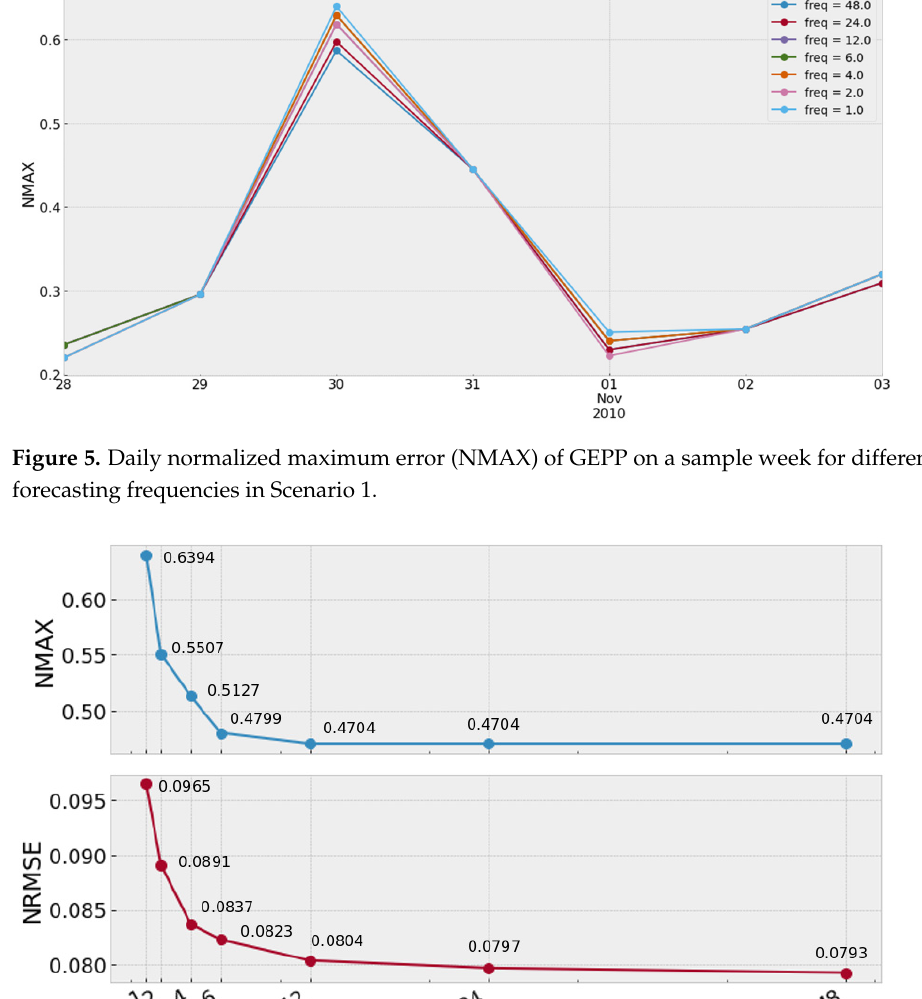
Figure 6. Error metrics on GEPP for different values of daily forecasting frequency in Scenario 2.